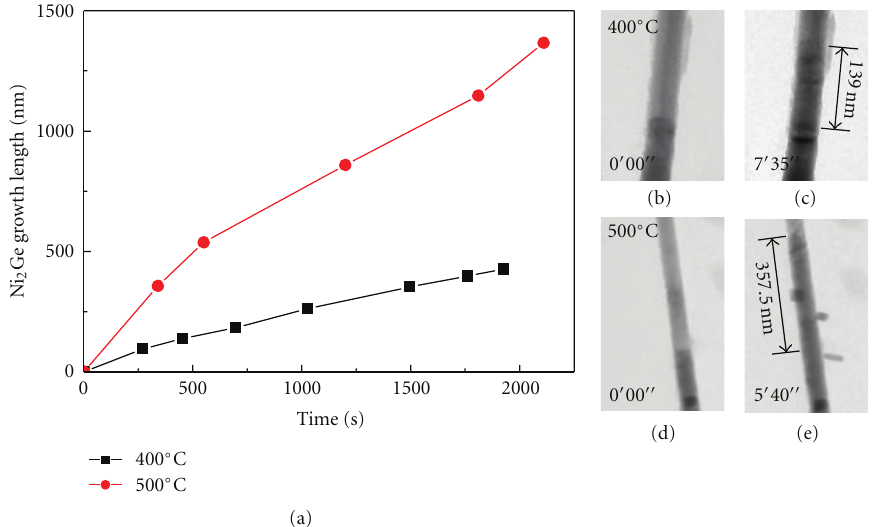
Figure 3: Kinetic analysis of the Ni 2 Ge epitaxial growth within Ge nanowires. (a) Real-time record of the Ni 2 Ge nanowire growth length versus the reaction time at 400 and 500 ◦ C, illustrating a potentially linear growth rate. (b)-(c) In situ TEM images of the Ni 2 Ge growth within a Ge nanowire at 400 ◦ C annealing. The arrow indicates a corresponding length of 138.9 nm growth in 7min 35 sec. (d)-(e) In situ TEM images of the Ni 2 Ge growth within a Ge nanowire at 500 ◦ C annealing. The arrow indicates a corresponding length of 357.5 nm growth in 5min 40 sec. Reproduced from